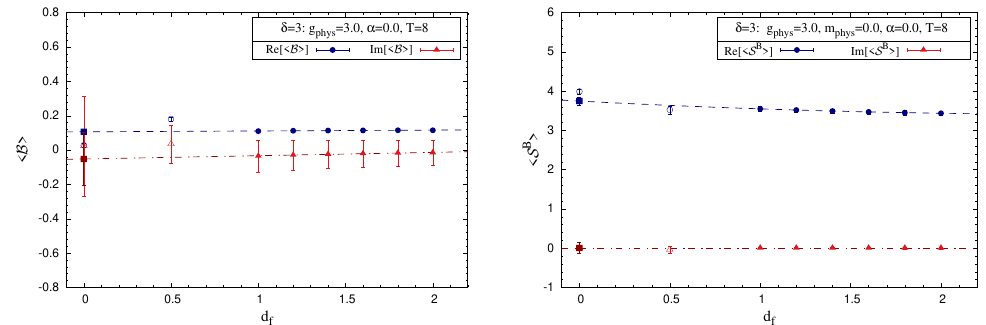
Figure 10 . The δ = 3 model. Expectation values of B α (left) and S B deformation d f parameter on a T = 8 lattice. The parameters used are g phys = 3 , m phys = 0 , and α = 0 . 0 . The dashed curves represent extrapolations to the d f → 0 limit.